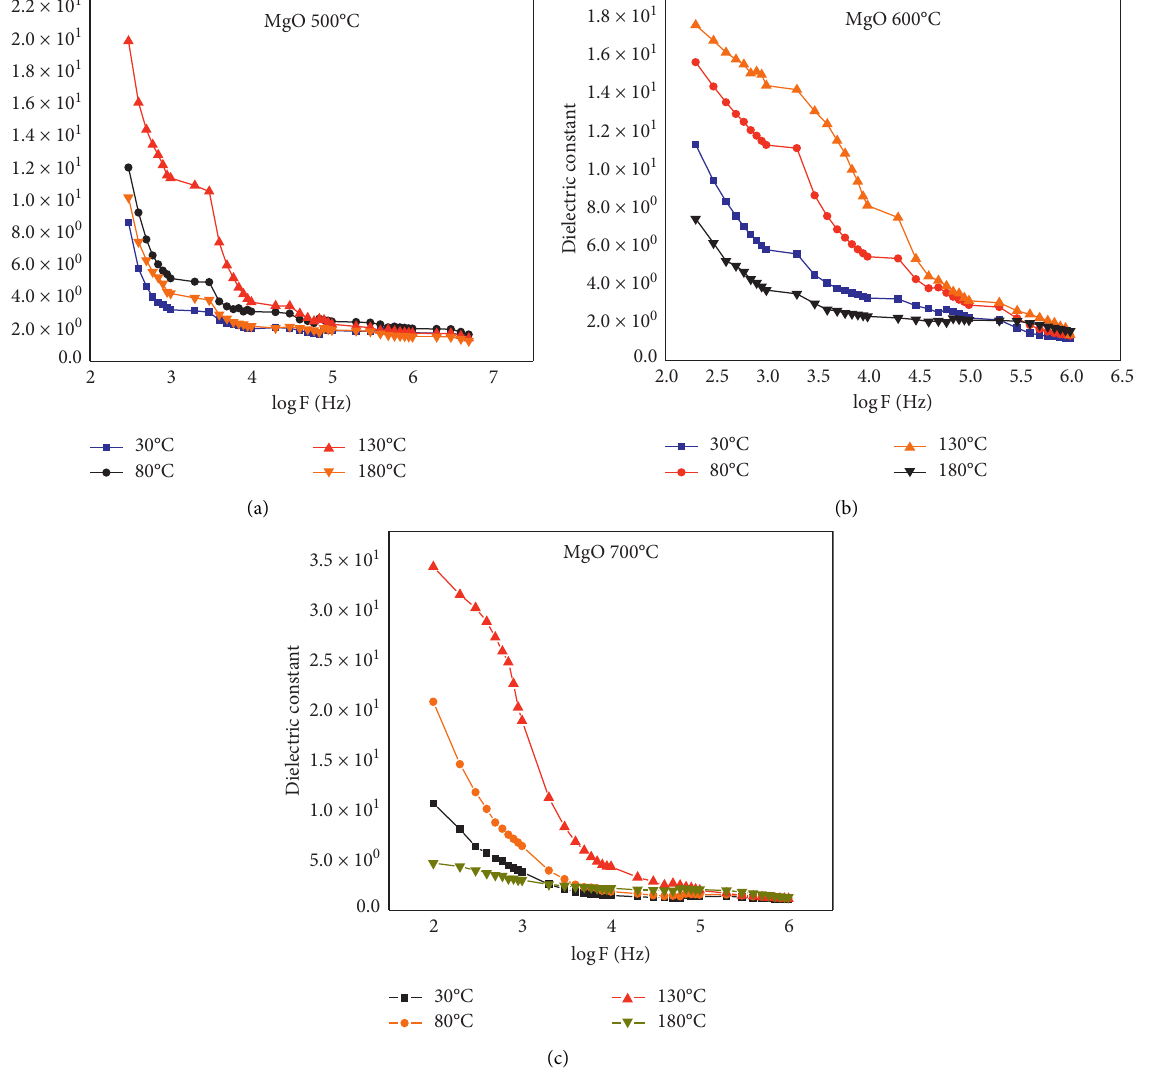
Figure 14: Dielectric constant of MgO nanoparticles at 500 ° C (a), 600 ° C (b), and 700 ° C (c) with different